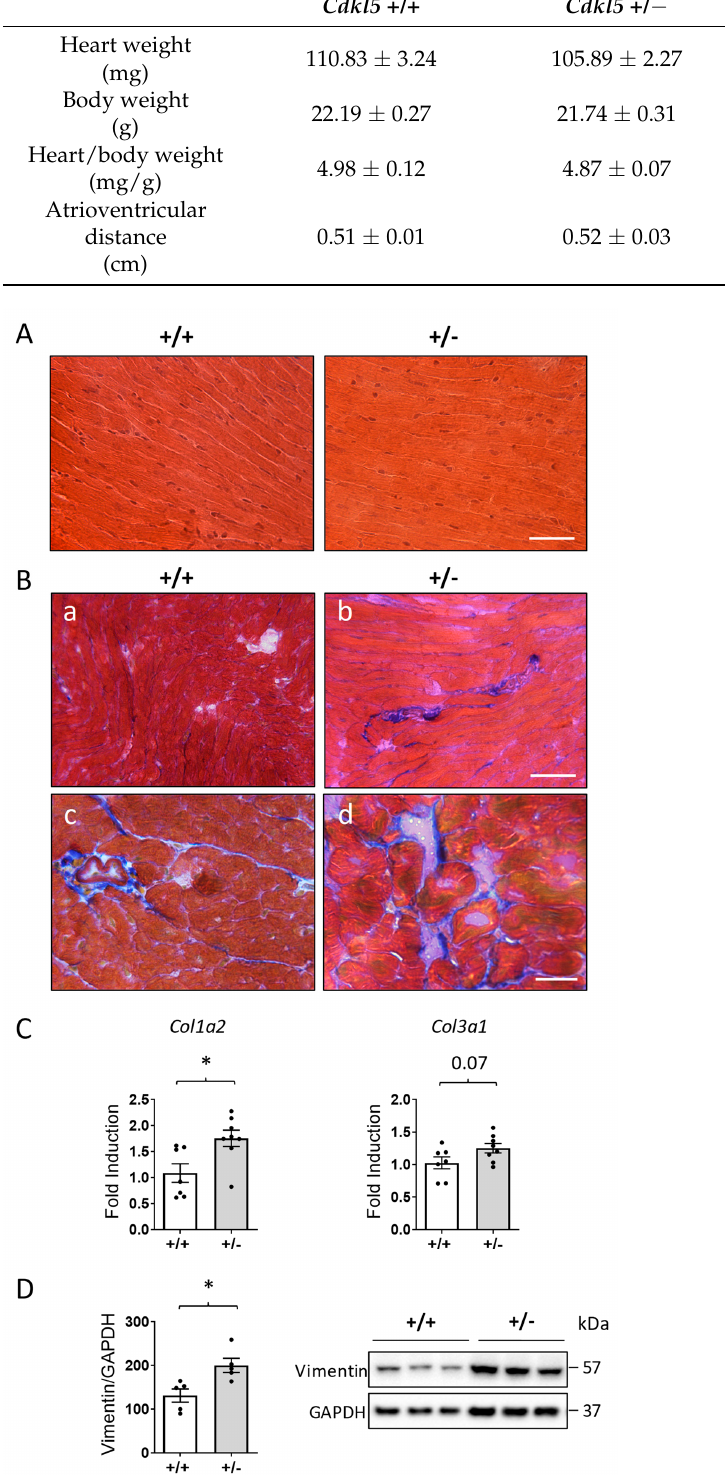
Figure 2. Myocardial fibrosis in the heart of Cdkl5 +/ − mice. ( A ) Representative images of hema- toxylin and eosin staining of longitudinal sections of the ventricular tissue of Cdkl5 +/+ (left panel) and Cdkl5 +/ − (right panel) mice. Scale bar = 50 µ m. ( B ) Representative images of Masson’s